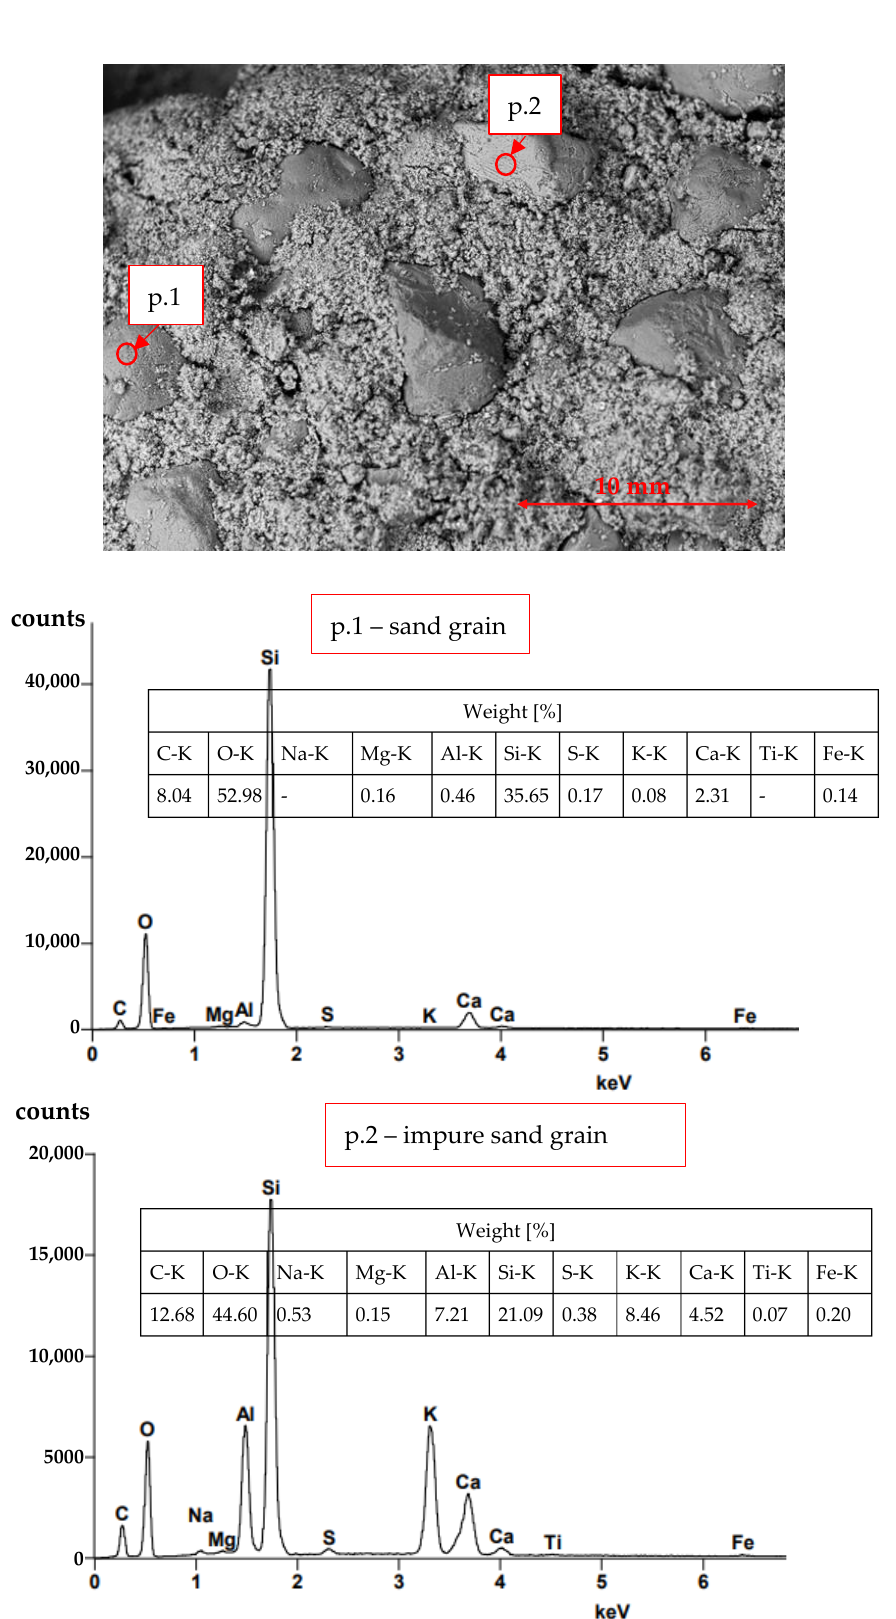
Figure 2. The semi-quantitative SEM-EDS analysis of self-destructed lime mortar with 30% fluidised fly bed ash, F30.